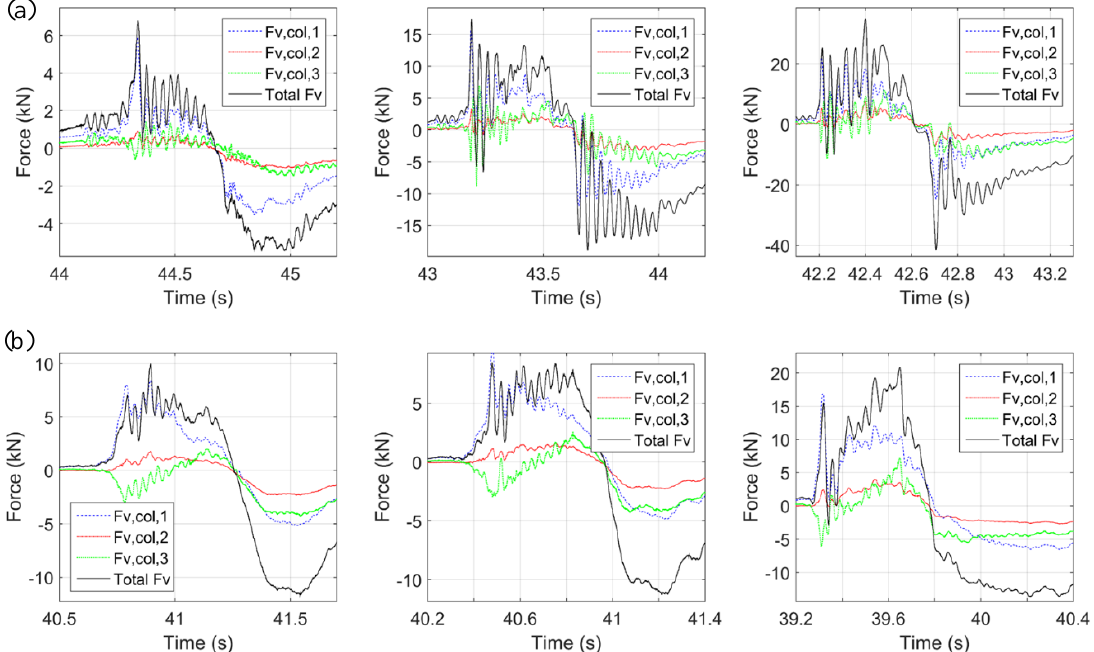
Figure 9. Vertical force histories in column-bent cap connections for ( a ) solitary waves (top) with H = 0.42 m (left), H = 0.55 m (center) and H = 0.70 m (right), and ( b ) bores (bottom) with H = 1.0 m (left), H = 1.10 m (center) and H = 1.40 m (right).